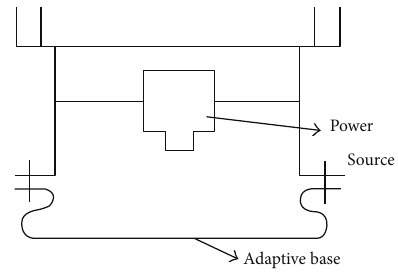
Figure 4: A schematic diagram of elastic